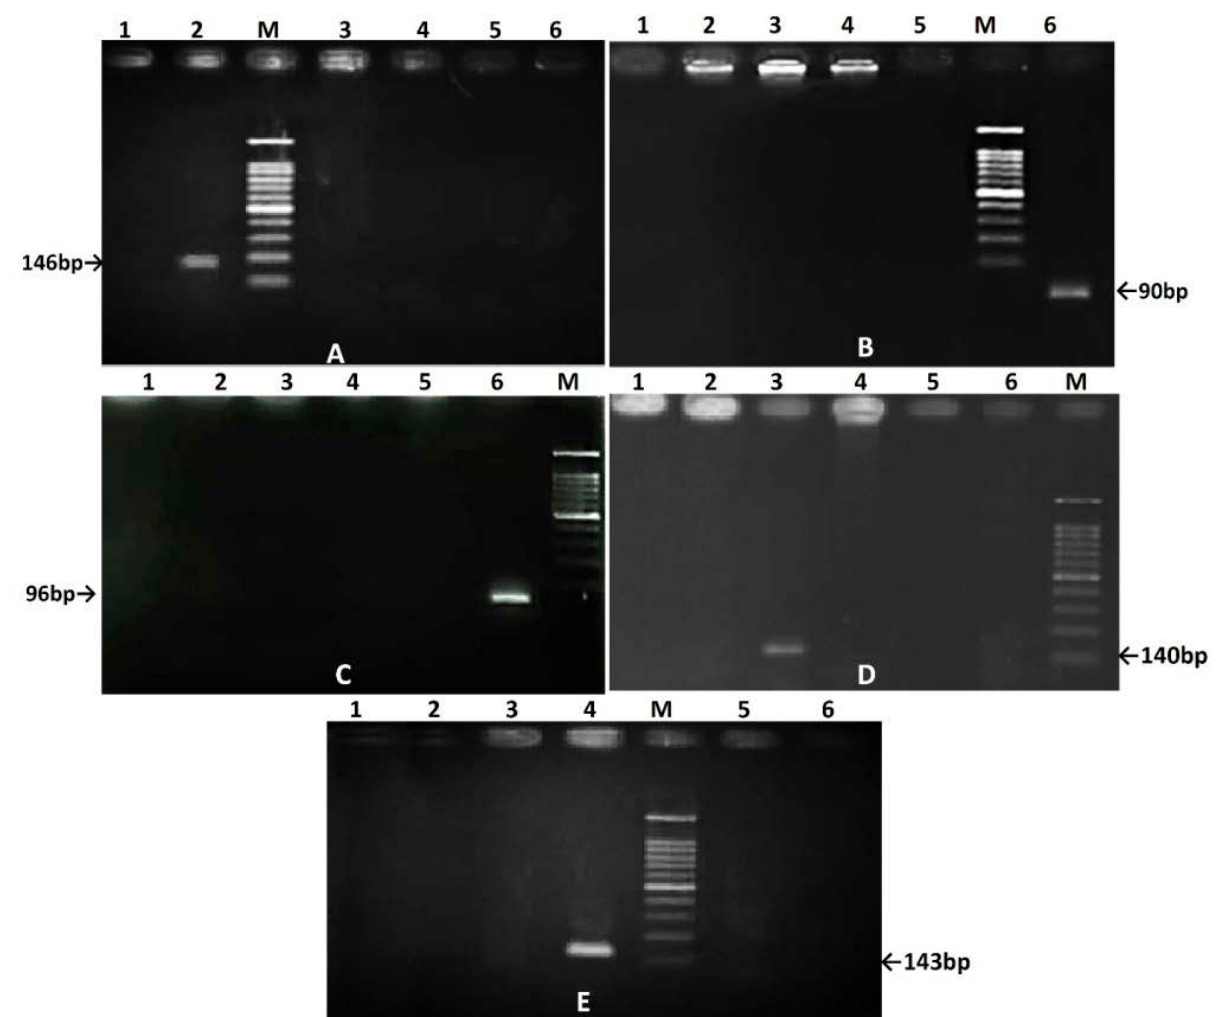
Figure 3. Agarose gel electrophoresis pattern of nested PCR products using P1/P7 primer pair followed by primer pairs LWB F /LWB R (146 bp) for detection, in singly graft-inoculated periwinkle plants, of lime witches’ broom phytoplasma (LWBP) (A); AWB F /AWB R (90 bp), for alfalfa witches’ broom phytoplasma (AWBP) (B); TWB F /TWB R (96 bp), for tomato witches’ broom phytoplasma (TWBP) (C); RPh F /RPh R (140 bp), for rapeseed phyllody phytoplasma (RSPh) (D); and SPh F /SPh R (143 bp), for sesame phyllody phytoplasma (SPhP) (E). In A, B, D, and E, lanes 1, 2, 3, 4, 5, 6 are from, respectively, healthy periwinkle, LWBP, RPhP, SPhP, TWBP or AWBP graft-inoculated periwinkle plants. In C, lanes 1, 2, 3, 4, 5, 6, are from, respectively, healthy periwinkle, LWBP, RPhP, SPhP, AWBP or TWBP graft-inoculated periwinkle plants. M, 100 bp DNA marker fragments (Fermentas, Vilnius,